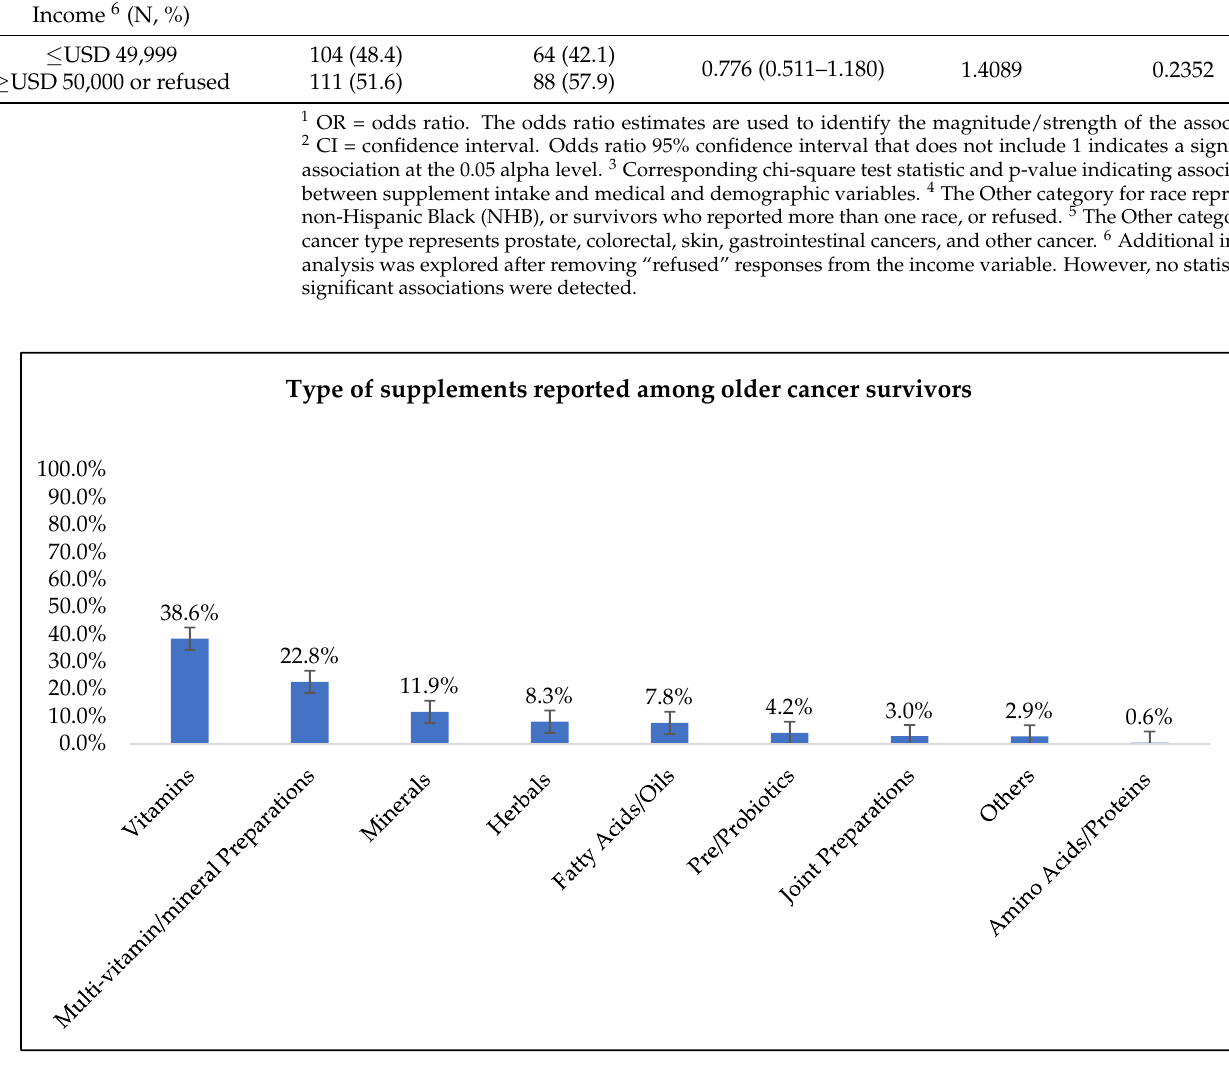
Figure 1. Types of dietary supplements reported among older cancer survivor supplement users ( n = 215).